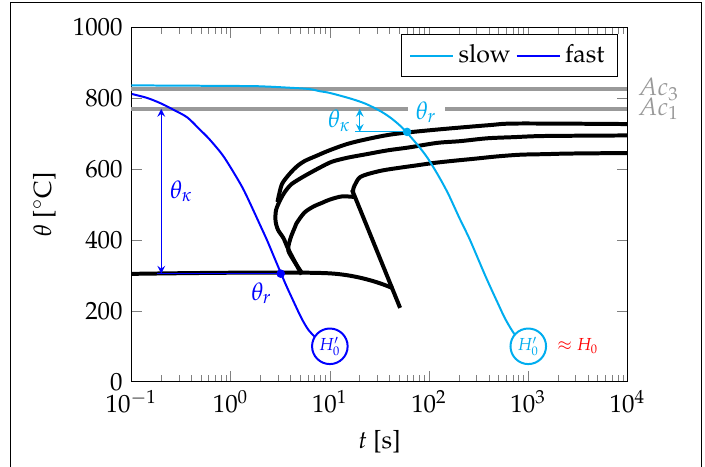
Figure 2. Extraction of κ , θ κ for fast and slow cooling